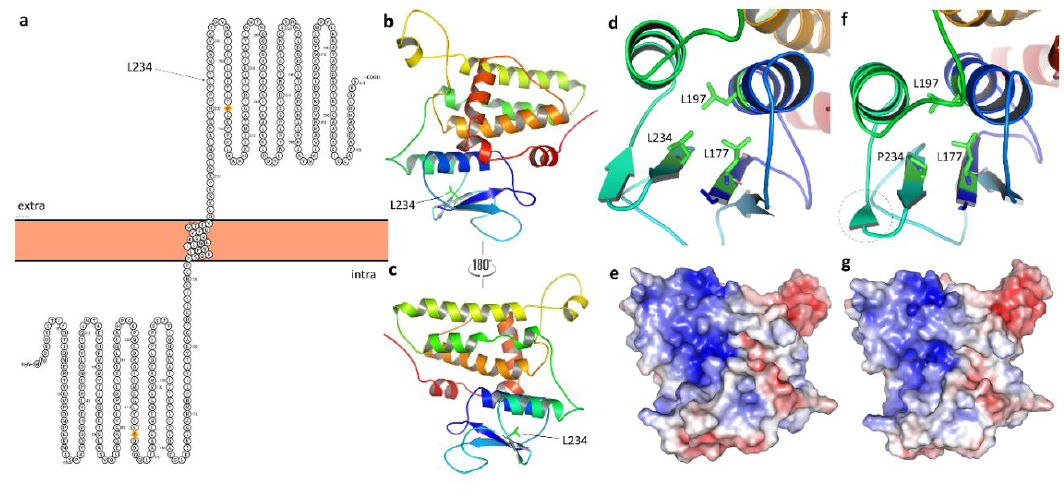
Figure 3. ( a ) The residue Leu234 of NM_001114086.1:c.701T > C:p.(L234P), representing the long isoform of missense variant NM_016929.5:c.224T > C:p.(L75P) is located in the extracellular domain of the CLIC5 protein. ( b , c ) The overall structure of CLIC5 and the Leu234 residue (represented by a stick model). ( d ) Close-up view of the interaction pattern at position 234 of wild-type and mutant protein ( f ). Due to the mutation, the shortness of the β-strand observed in the mutant protein was highlighted by a dotted-circle. ( e ) The surface charge distribution of wild and ( g ) mutant CLIC5. Intra: intracellular; extra: extracellular.